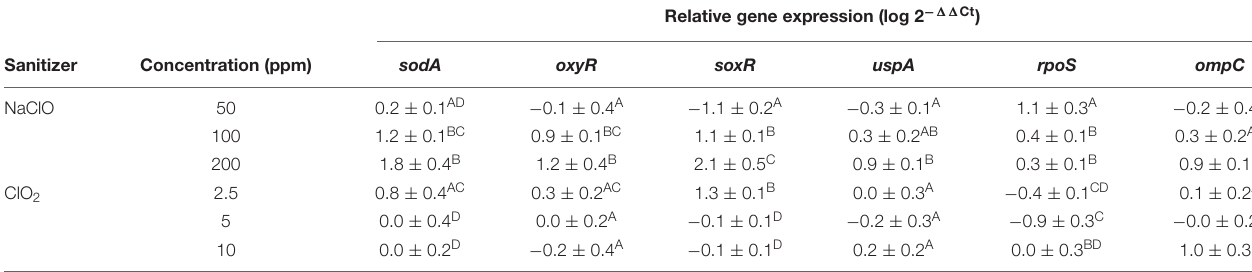
Relative gene expression (log 2 − (cid:49)(cid:49) Ct )